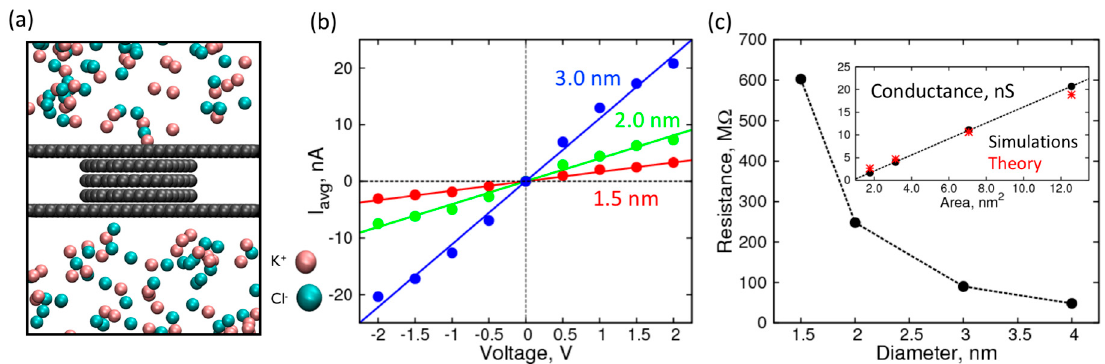
Figure 3. Characterization of empty nanopores of various sizes: ( a ) Simulation snapshot of the nanopore system; ( b ) I-V curves in 1 M KCl over a range of ± 2 V through an empty nanopore made of 5-layered graphene of size 1.5 nm (red), 2.0 nm (green), and 3.0 nm (blue); ( c ) Resistance (M Ω ) of the nanopore as a function of pore diameter. Inset: Comparison of theoretical (red asterisks), and simulated (black circles) conductance (nS) as a function of cross-sectional area of the